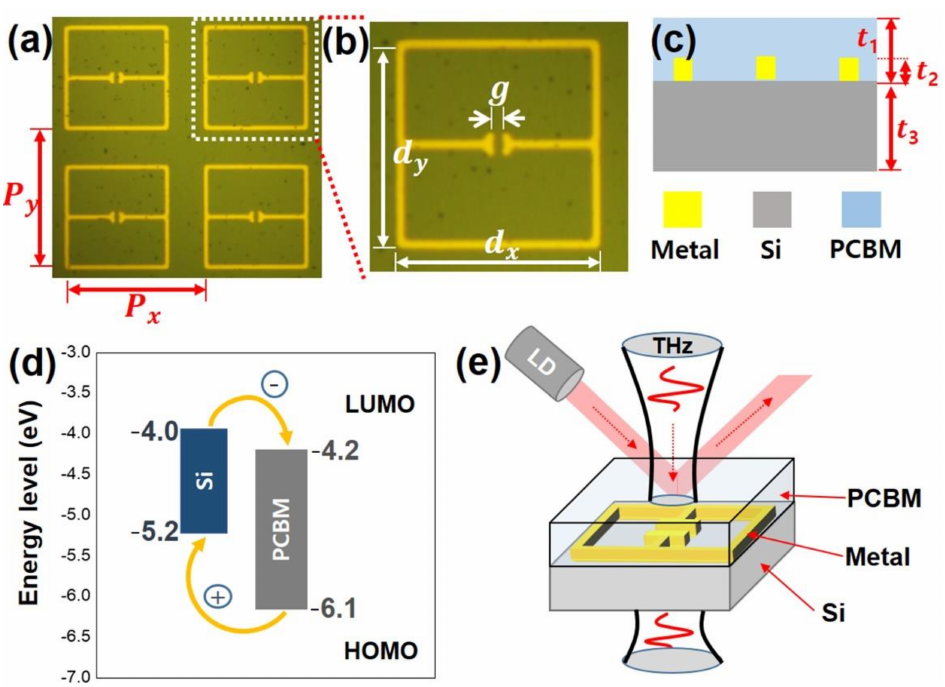
Figure 1. ( a ) Microscopic image of the sample with PCBM/metamaterial/Si hybrid structure. ( b ) Geometry and dimensions of an individual unit cell. Yellow and dark-green parts are metamaterial and Si substrate, respectively. ( c ) Schematic side view in section through the X–Z plane. ( d ) An energy-level diagram showing the highest occupied molecular orbital (HOMO) and lowest unoc- cupied molecular orbital (LUMO) energy levels of the PCBM/Si hybrid structure. ( e ) Experimental configuration for THz transmission measurements on a